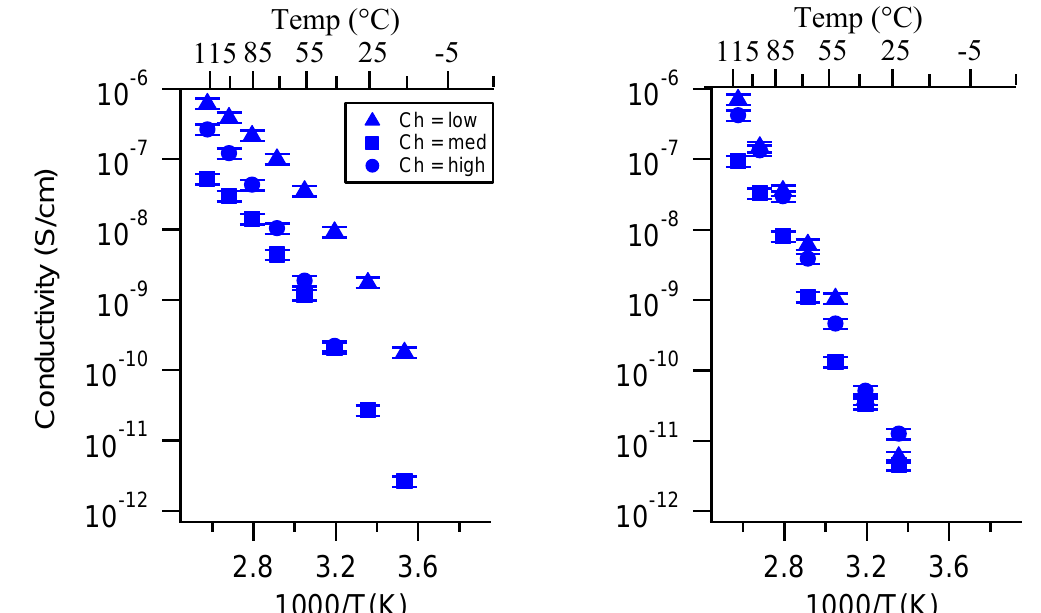
Figure A22. Conductivity as a function of charge density for PEGDMA1000_SSNa (left) and PTHFDA1000_STFSINa (right) SIPEs dry. Temperatures ranged from − 20 °C to 115 °C. Note that there may be a non ‐ negligible fraction of electronic conductivity in conditions where conductivity of less than 10 − 9 S/cm is reported.